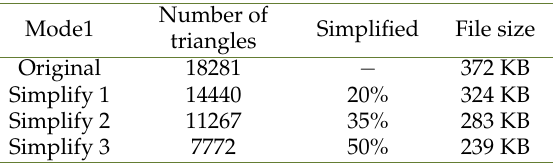
Table 3. Comparison of model simplification data